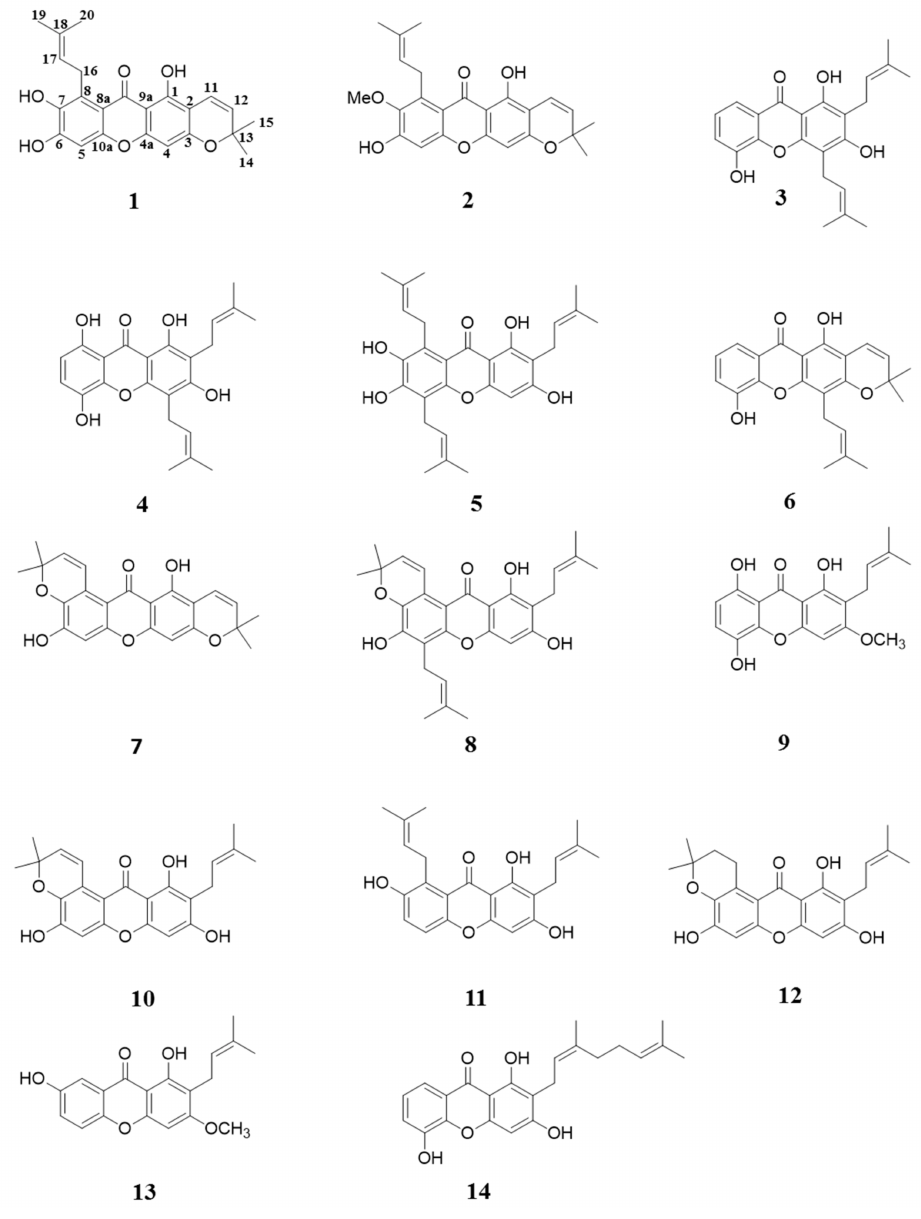
Figure 1. Chemical structure of xanthones 1 – 14 isolated from Garcinia mangostana L. Table 1. 1 H- and 13 C-NMR spectral data of compound 1 in DMSO- d 6